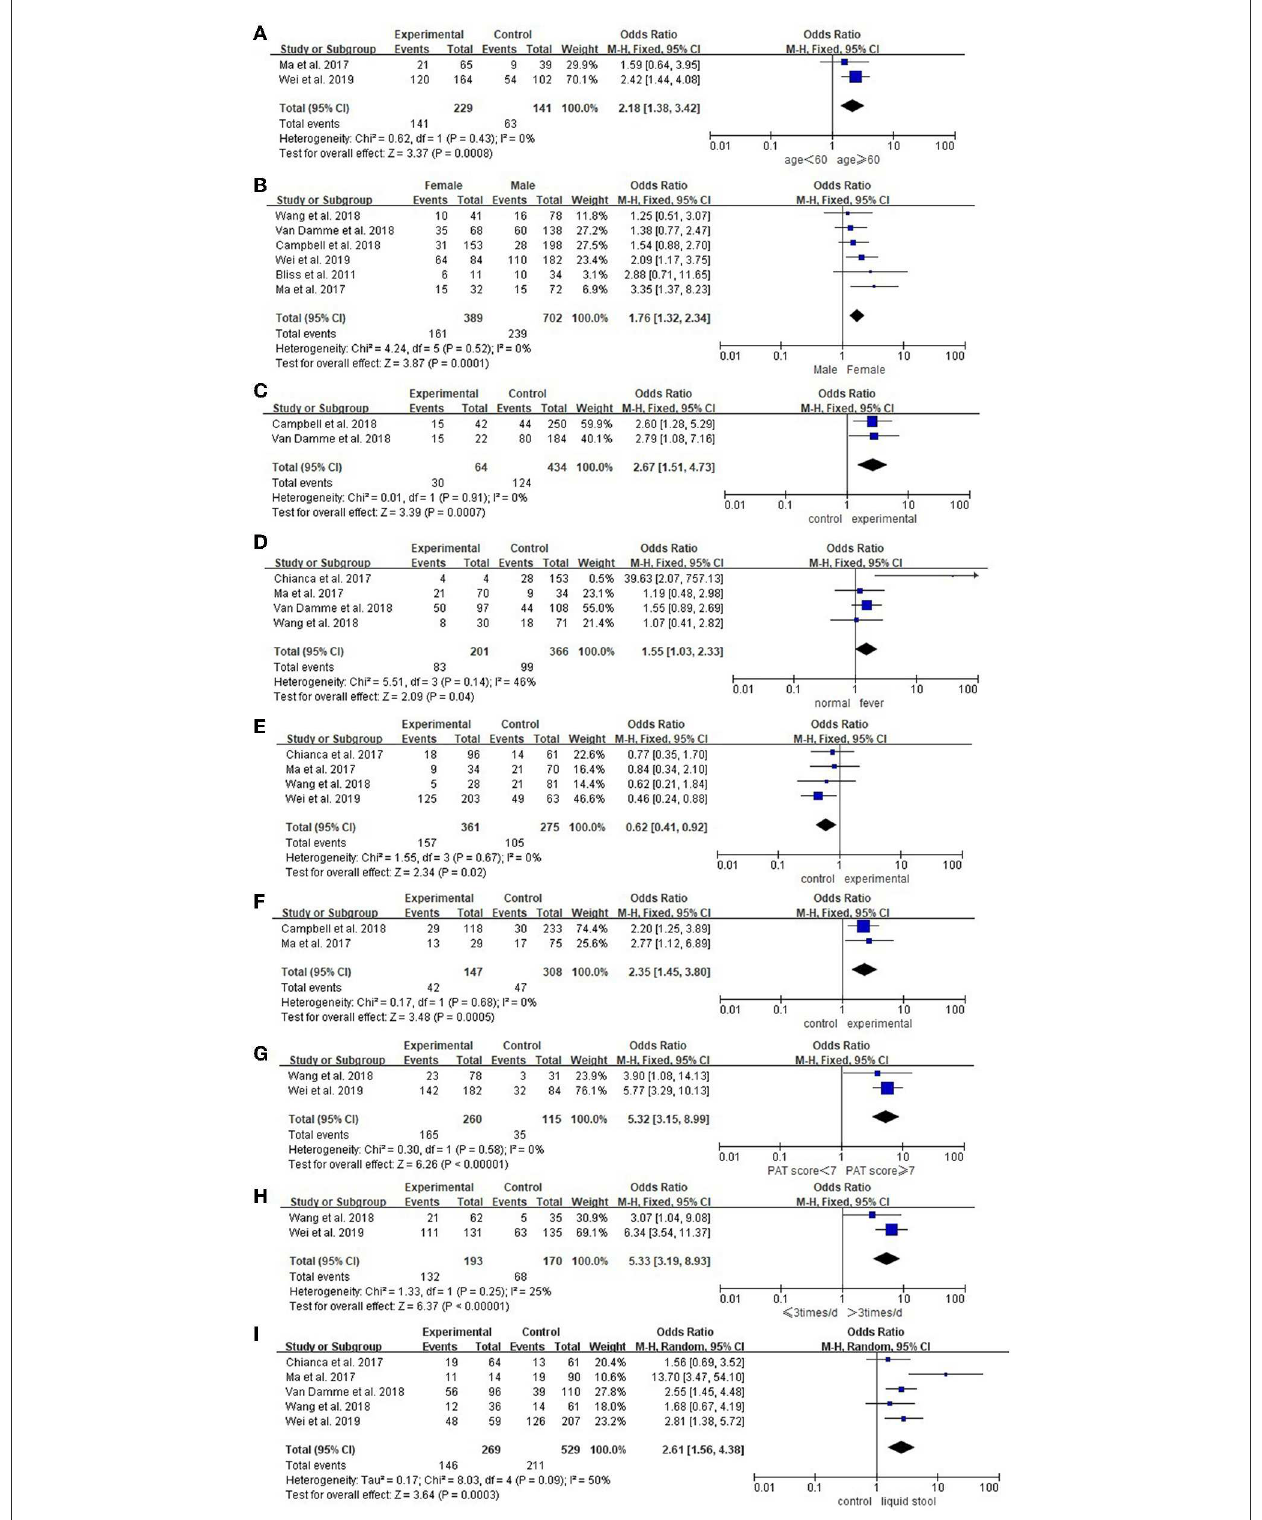
FIGURE2 Forest plots of risk factors of IAD in critically ill patients. (A) Age; (B) Gender; (C) Dialysis; (D) Fever; (E) Sedative; (F) Vasoactive agent; (G) PAT score; (H) Frequency of bowel movement; (I) Liquid